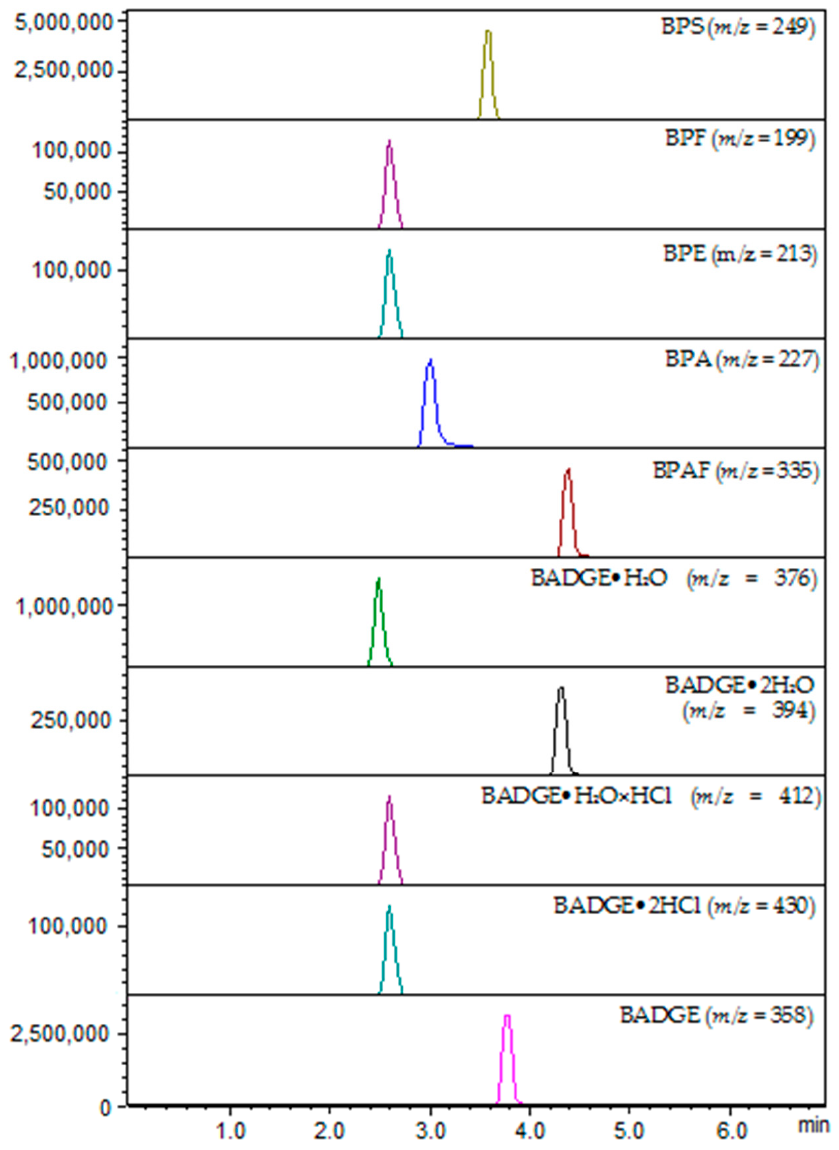
Figure 1. Representative MRM chromatograms of 10 studied bisphenols. BPS ( m / z = 249), BPF ( m / z = 199), BPE ( m / z = 213), BPA ( m / z = 227), BPAF ( m / z = 335), BADGE • 2H 2 O ( m / z = 394), BADGE • H 2 O ( m / z = 376), BADGE • H 2 O × HCl ( m / z = 412), BADGE • 2HCl ( m / z = 430), BADGE ( m / z =